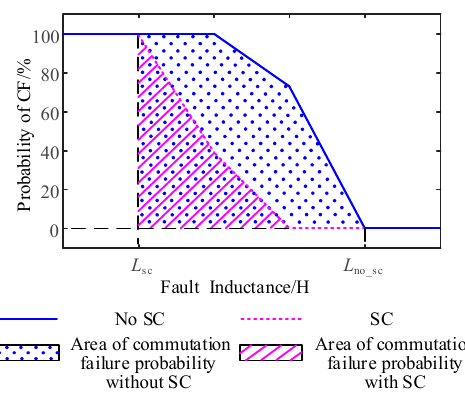
Figure 6. Schematic presentation of area of commutation failure probability with and without a SC.